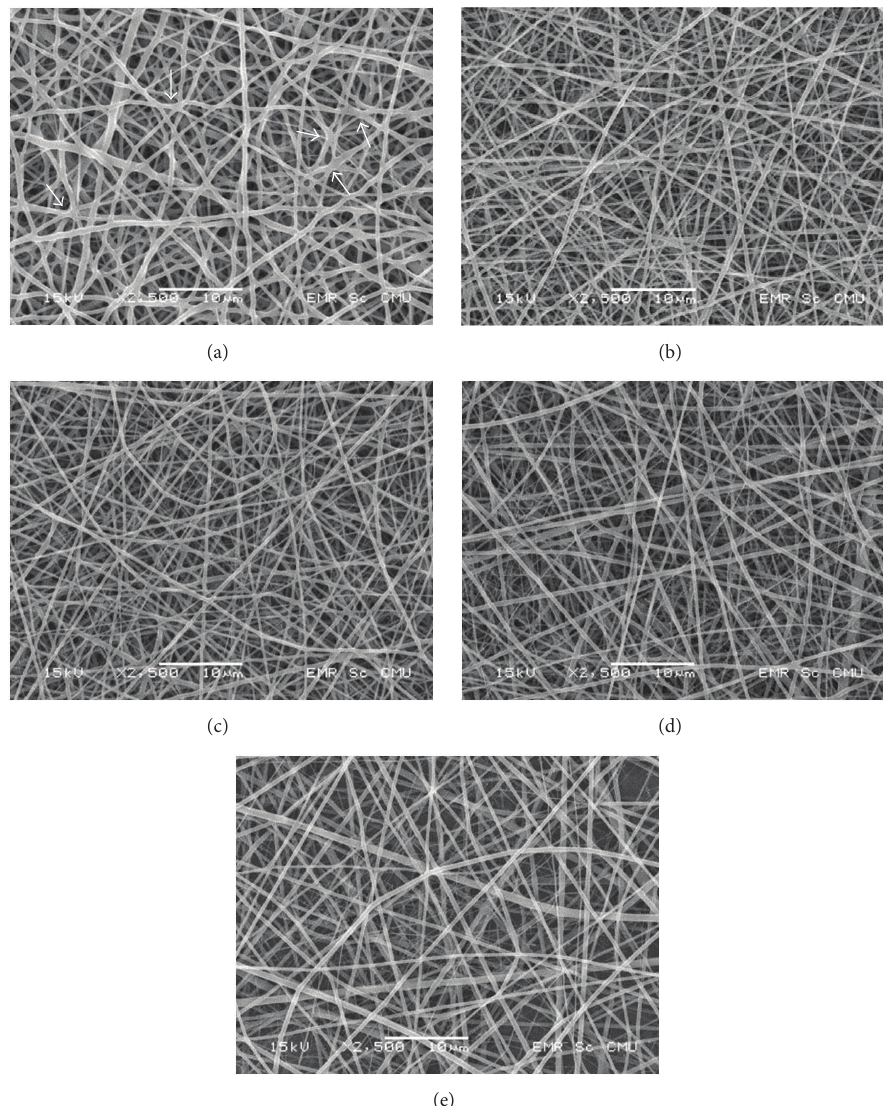
Figure 1: Photomicrographs of (a) PLCL 67: 33% mol solution, (b) PLCL-2.5SC, (c) PLCL-5SC, (d) PLCL-7.5SC, and (e) PLCL-10SC electrospun blended membranes (scale bar 10 𝜇 M). Interfiber contacted merging (IFCM) is indicated on (a) by the arrow